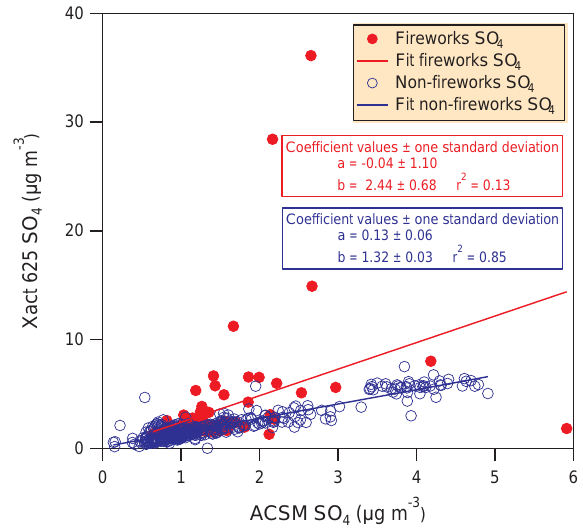
Figure 5. Comparison of Xact PM 10 SO 4 vs. ACSM PM 1 SO 4 . Data were split into fireworks (red) and non-fireworks (blue) peri-